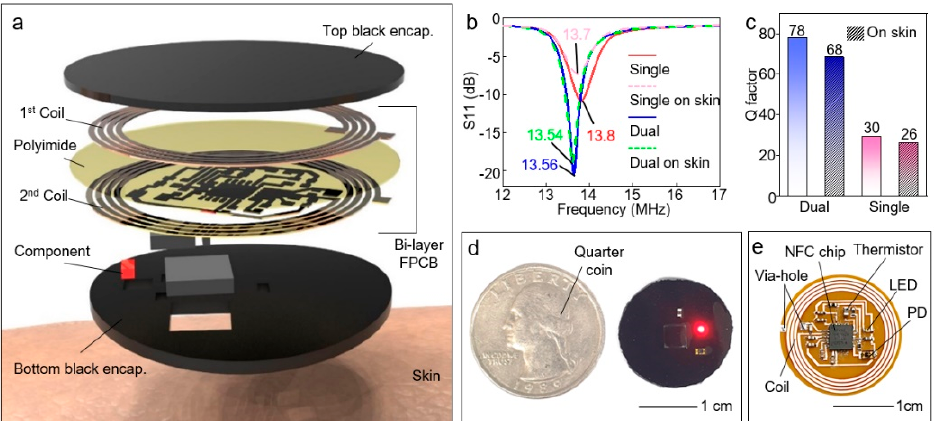
Figure 1. Near-field communication (NFC) based wireless device. ( a ) Exploded view of schematic illustration of the wireless device. ( b ) Measured frequency characteristics of single-layer and dual-layer devices in both cases of devices on a slide glass and devices on skin. ( c ) Q-factor of dual-layer and single-layer device attached to the skin. ( d ) Image of black encapsulated device with Quarter coin. ( e ) Photograph of unencapsulated wireless device.